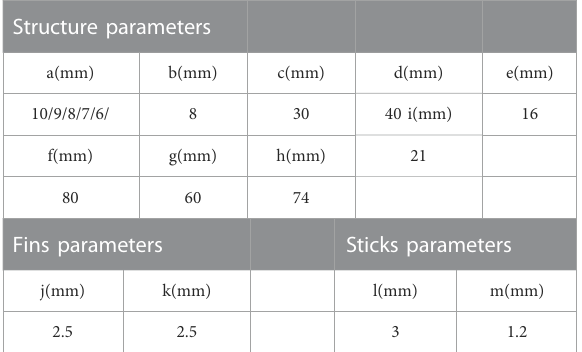
TABLE 1 Parameters of cold